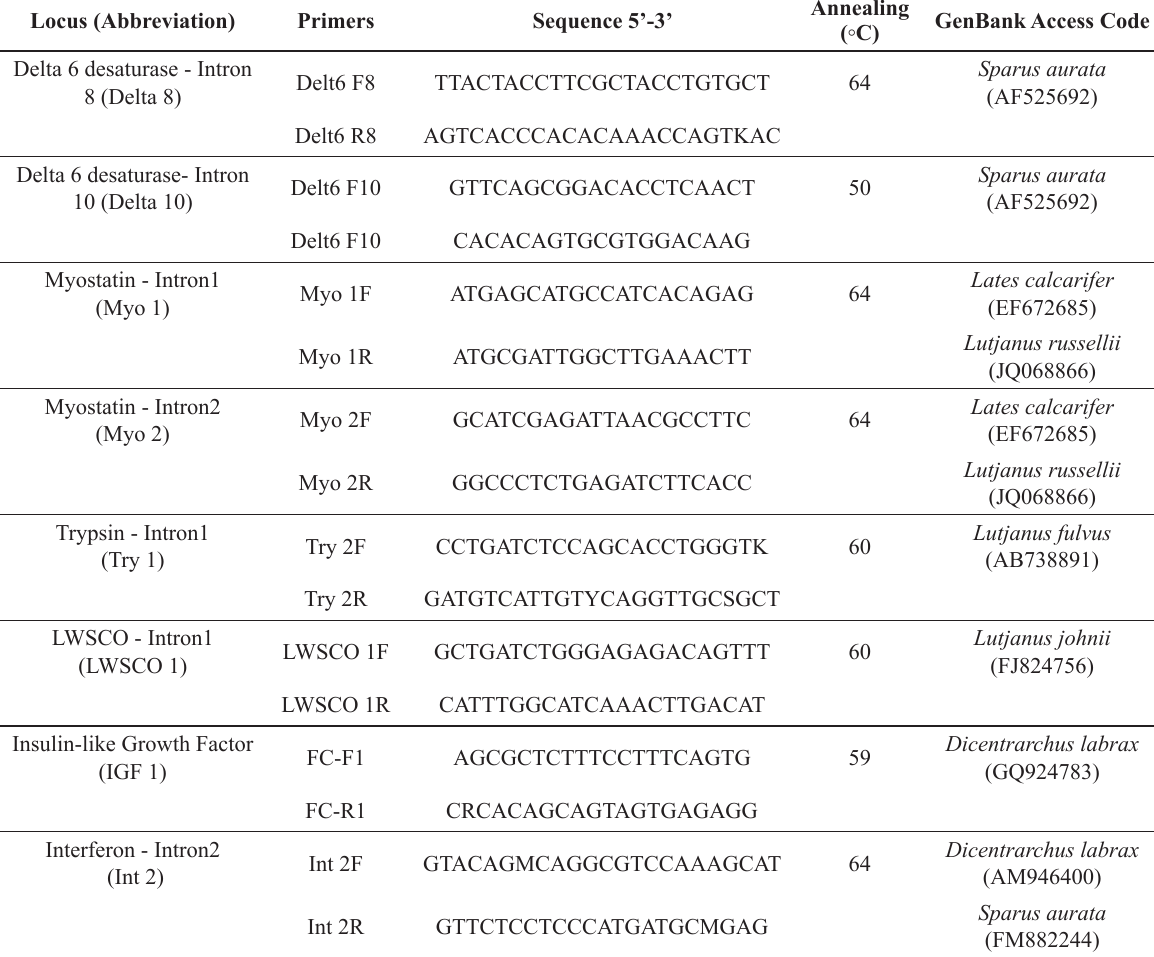
Description for the markers developed in the present